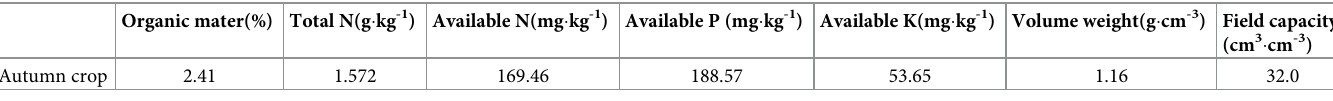
Table 1. Soil physical and chemical properties in the